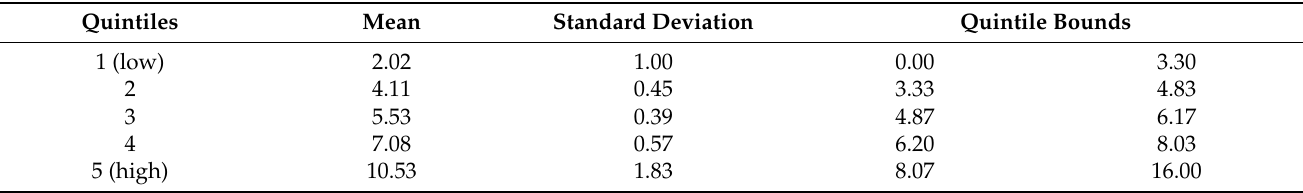
Table 3. Description of the nature space total quality score quintile